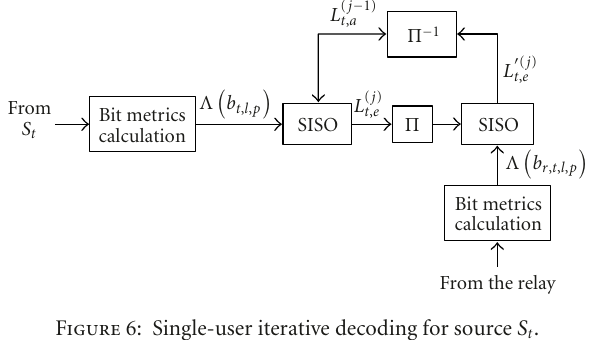
Figure 6: Single-user iterative decoding for source S t .